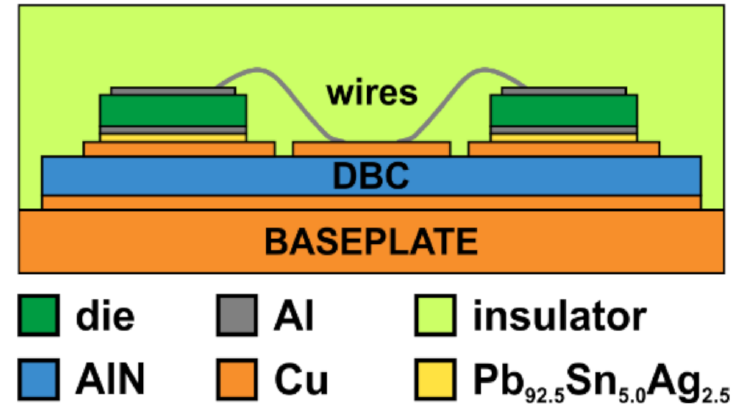
Figure 1. Picture of the state-of-the-art PM under investigation: it embeds four 3.3 kV SiC VDMOS transistors placed on two separate DBC substrates, which in turn lie on a 120 × 60 mm 2 Cu baseplate.